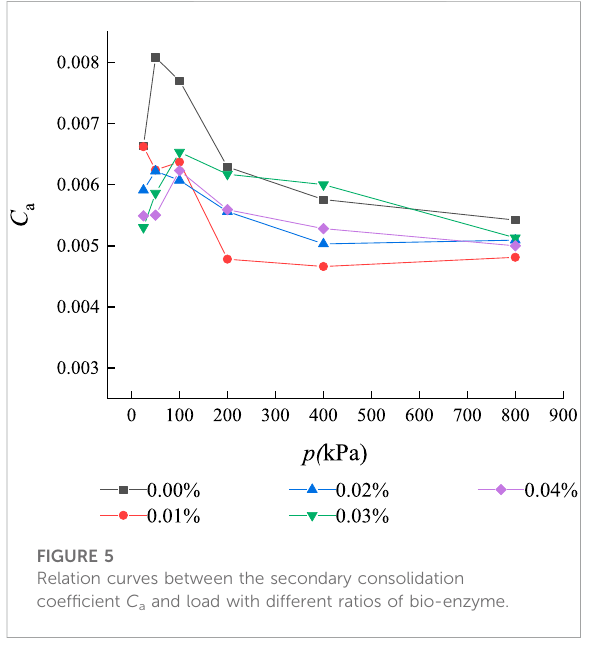
FIGURE 7 Relationship curve between C a and C c .